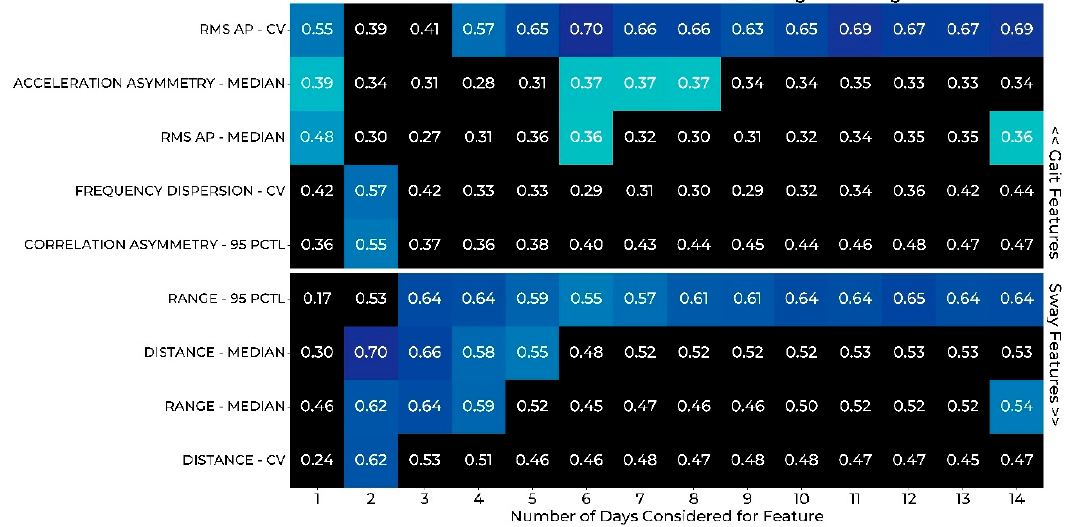
Figure 2. Spearman correlation between Activity-Specific Balance Confidence (ABC) and measures of gait and postural sway by number of sensor-wear days. Cells shaded in blue represent significant correlations (more green = weaker, more blue = stronger) and cells shaded in black were not signif- icant. PCTL: Percentile; CV: Coefficient of Variation; RMS: Root Mean Square; AP: Anterior-Poste- rior; ML: Medial-Lateral.